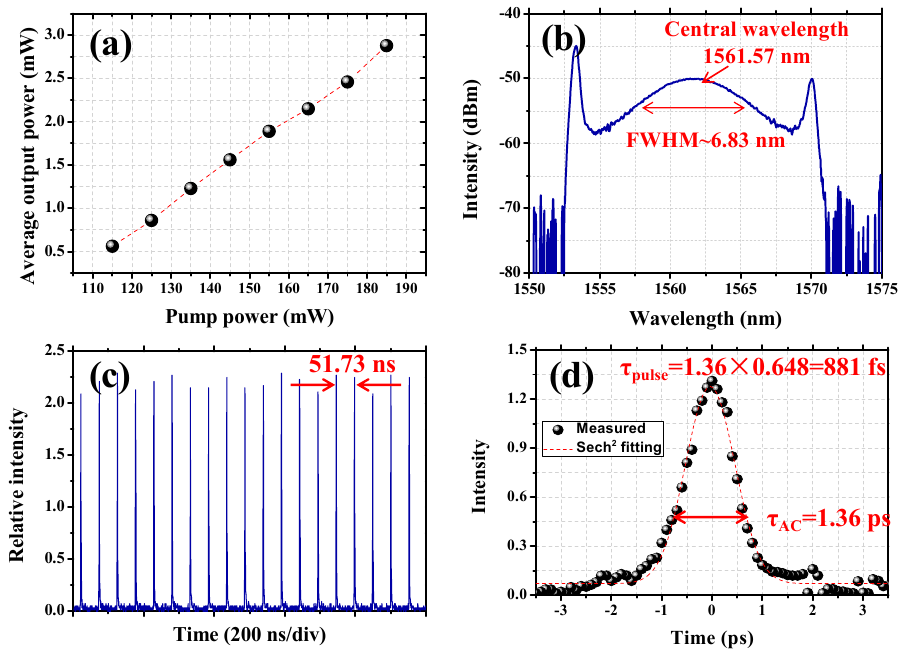
Figure8. ( a )Averageoutputpowerscalingasafunctionofpumppower; ( b )opticalspectrumatmaximal output power; ( c ) typical pulse train of the output laser at maximal output power; ( d ) autocorrelation trace of the output laser at maximal output